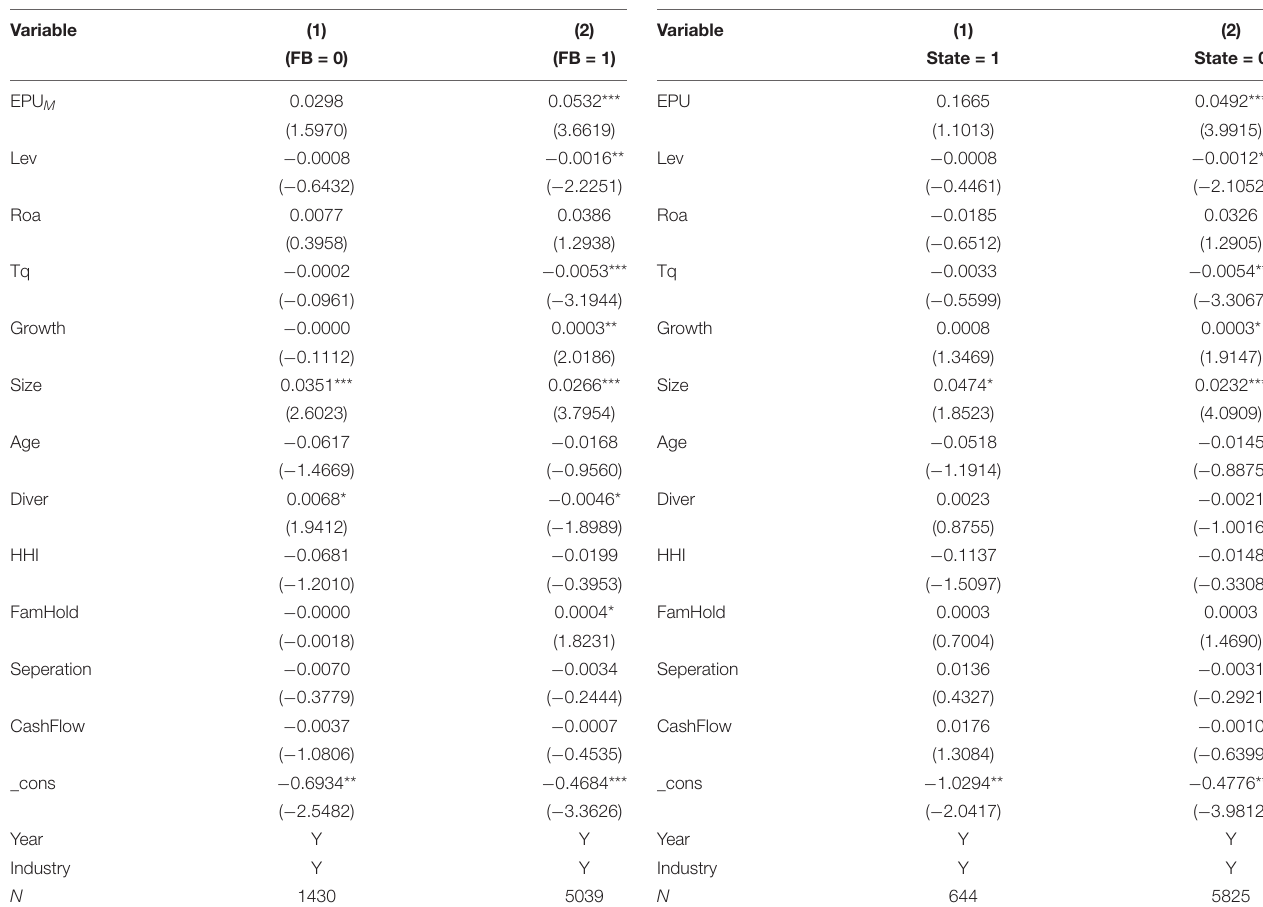
TABLE 4 | Group inspection of family firm’s executives with financial background. TABLE 5 | Group inspection of state-owned equity participation in family